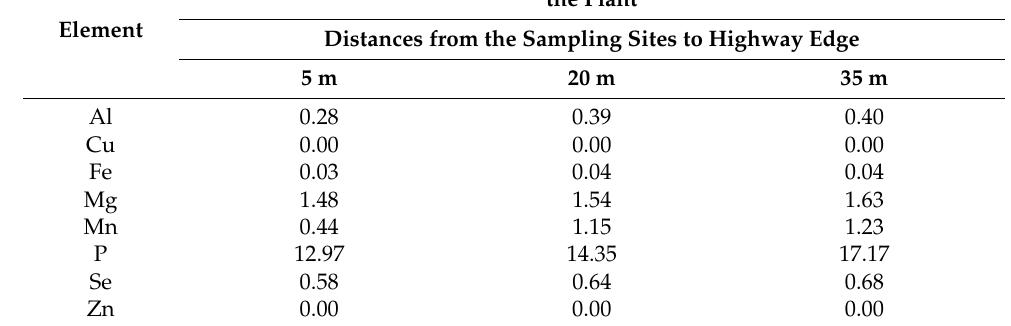
Table 3. Transfer factor of chemical elements in soils collected at three distances from the sampling sites from highway edge (D1, D2 and D3) to the trunk xylem sap. Transfer Factor of Concentrations of Elements in Soil to Trunk Xylem Sap of the Plant Element